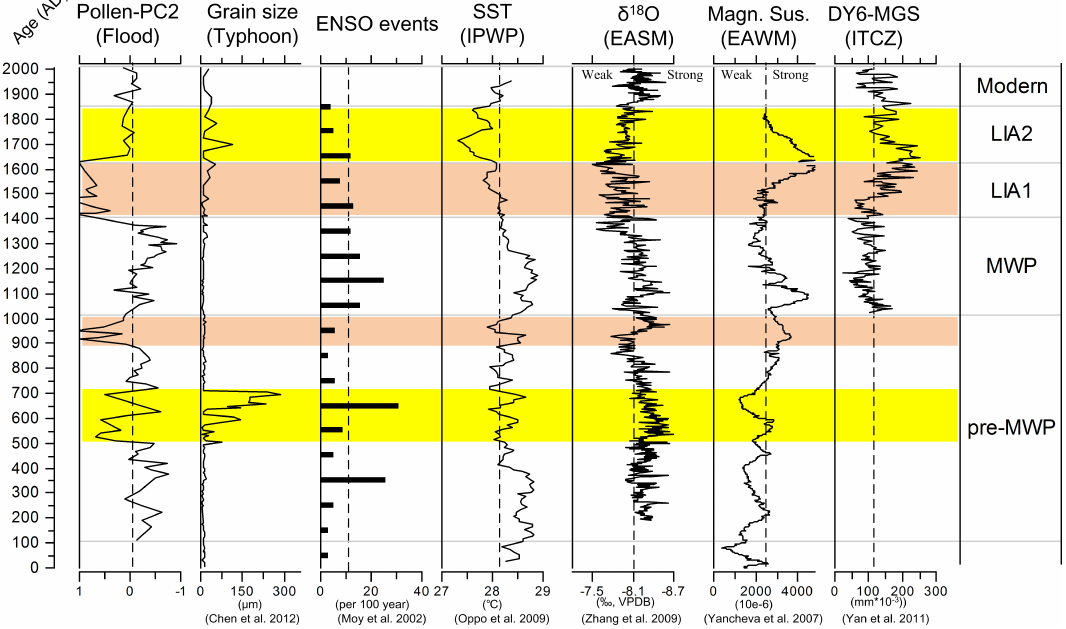
Figure 9. Variation of flood events and typhoon frequency in Taiwan over the last 1900 years by comparing with reconstructed proxy records of ENSO events (Moy et al., 2002), IPWP (SST of Makassar Strait) (Oppo et al., 2009), East Asia summer monsoon (EASM – δ 18 O speleothem from Wanxiang Cave) (Zhang et al., 2009), East Asian winter monsoon (EAWM – magnetic susceptibility from lake sediments of Lake Huguang Maar) (Yancheva et al., 2009), and the shifts of ITCZ (grain size from lake sediments from Cattle Pond, Dongdao Island) (Yan et al., 2011). Yellow shades indicate periods with frequently occurring typhoons, while the red shades indicate a transition phase of alluvial plain with little flood